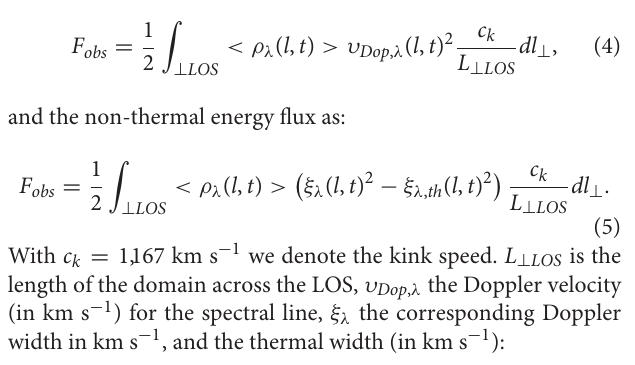
flux is followed by a drop, which is again more pronounced in the models with the stronger drivers. By comparing the curves for the models D2 and D4 with the synthetic images of Figure 2 , we see place that this drop takes place when the loops become turbulent due to the